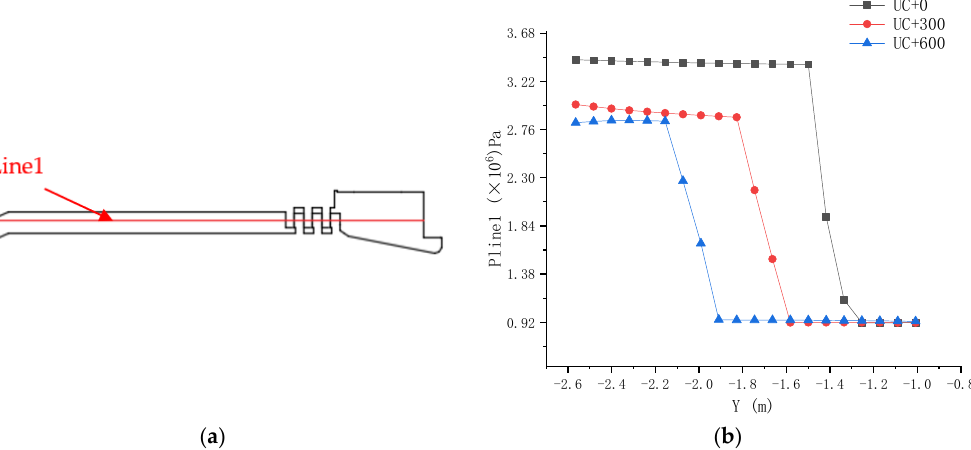
Figure 9. Radial pressure distribution diagrams of upper crown clearance. ( a ) The position distribution of line 1. ( b ) The radial pressure distribution along line 1.